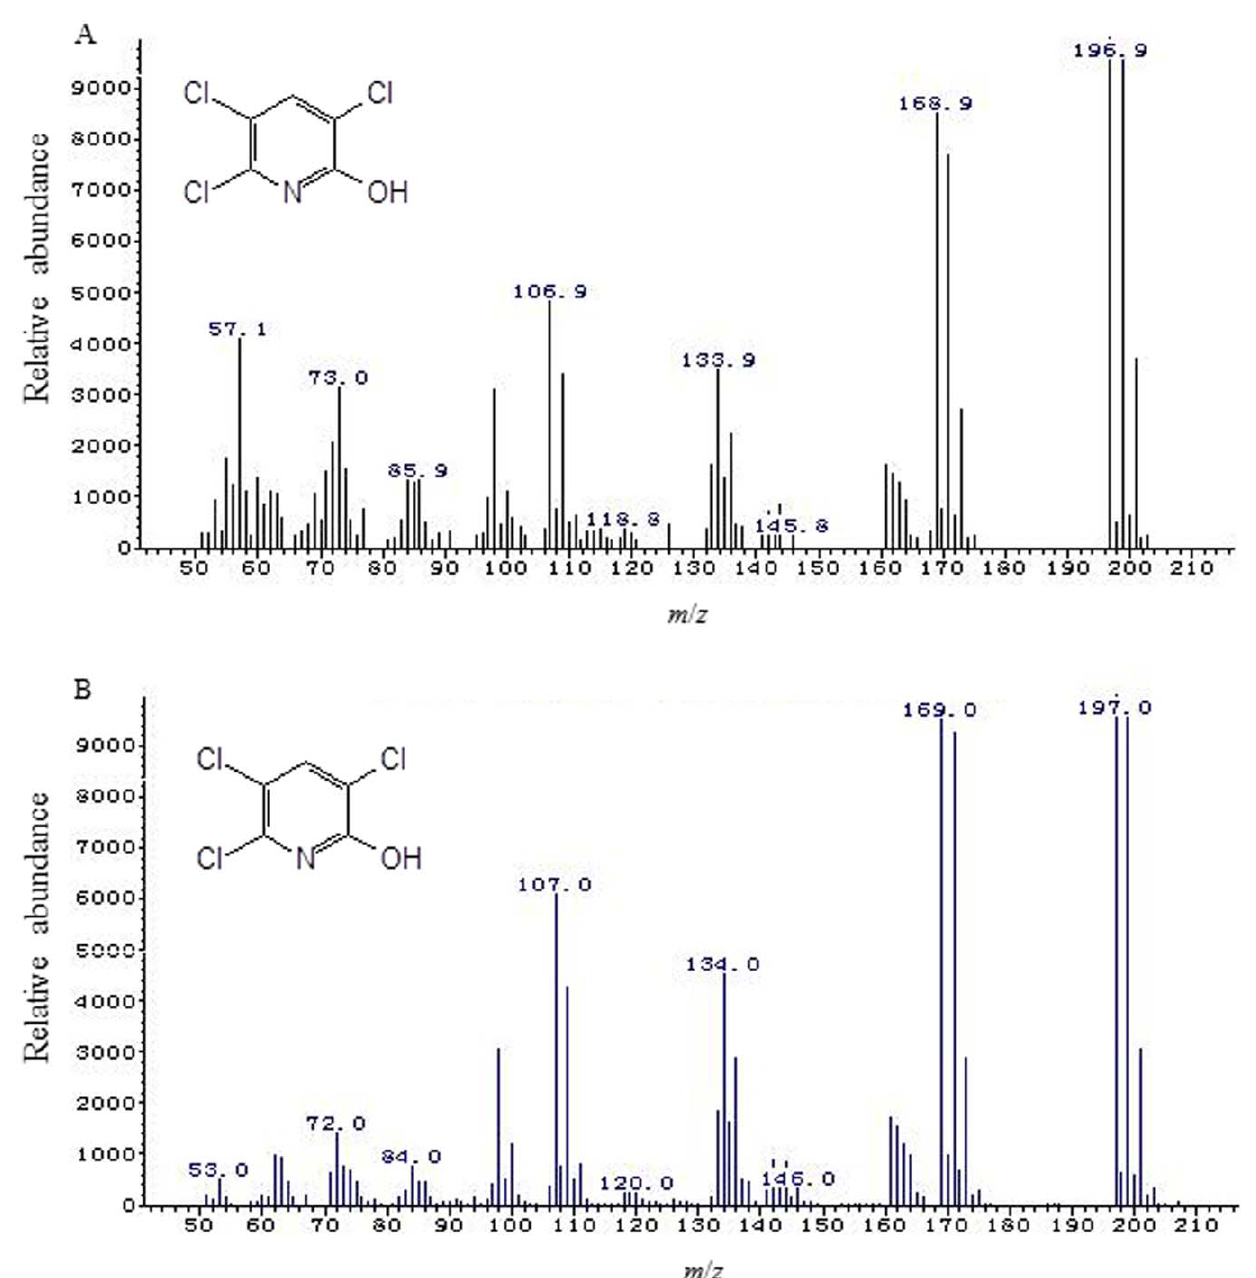
Figure 4. Mass spectra of 3,5,6-trichloro-2-pyridinol (TCP) produced from chlorpyrifos degradation by strain Hu-01. A: sample; B: authentic standard TCP from the National Institute of Standards and Technology (NIST, USA) library